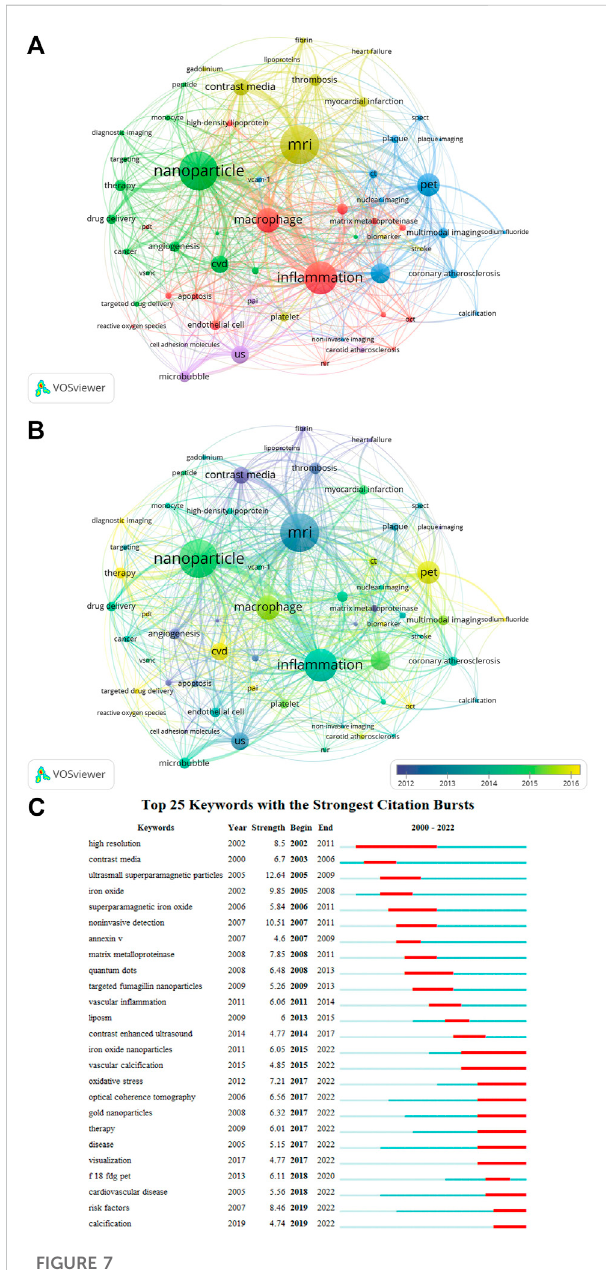
FIGURE 7 (A) The network of keywords co-occurrence conducted by VOSviewer. (B) Overlay map of keywords co-occurrence. The nodes inyellowandgreenrepresentthekeywordsappearingchronologically later than those in blue and purple. (C) Visualization of the top 25 keywords with the strongest citation bursts from 2000 to 2022 generated by CiteSpace.